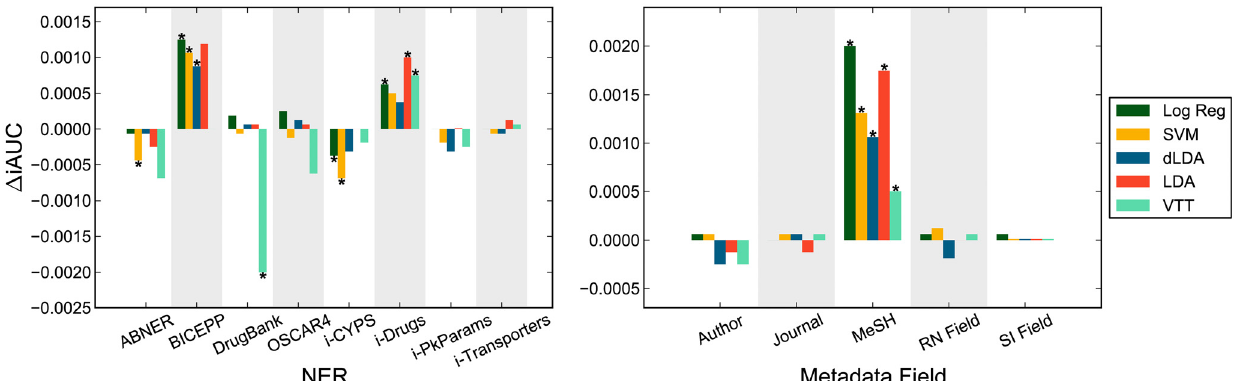
Fig 3. Performance impact of abstract NER and metadata features. Left: Relative changes in iAUC scores on non-transformed bigram runs in combination with different NER/Dictionary features. Significant changes ( p < 0.05, two-tailed test) in performance over the respective classifiers without NER features are indicated with asterisk ‘ * ’ . Right: Relative changes in iAUC when features from a given PubMed metadata field are included versus omitted (while including features from the other 4 metadata fields). Significant changes ( p < 0.05, two-tailed test) in performance are indicated with asterisk ‘ * ’